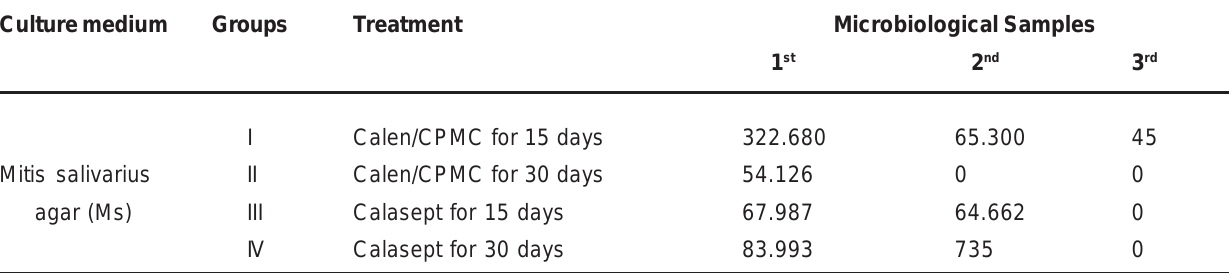
TABLE 2- Mean number of colony forming units of Streptococcus viridans in the agar culture medium mitis salivarius, in the four experimental groups